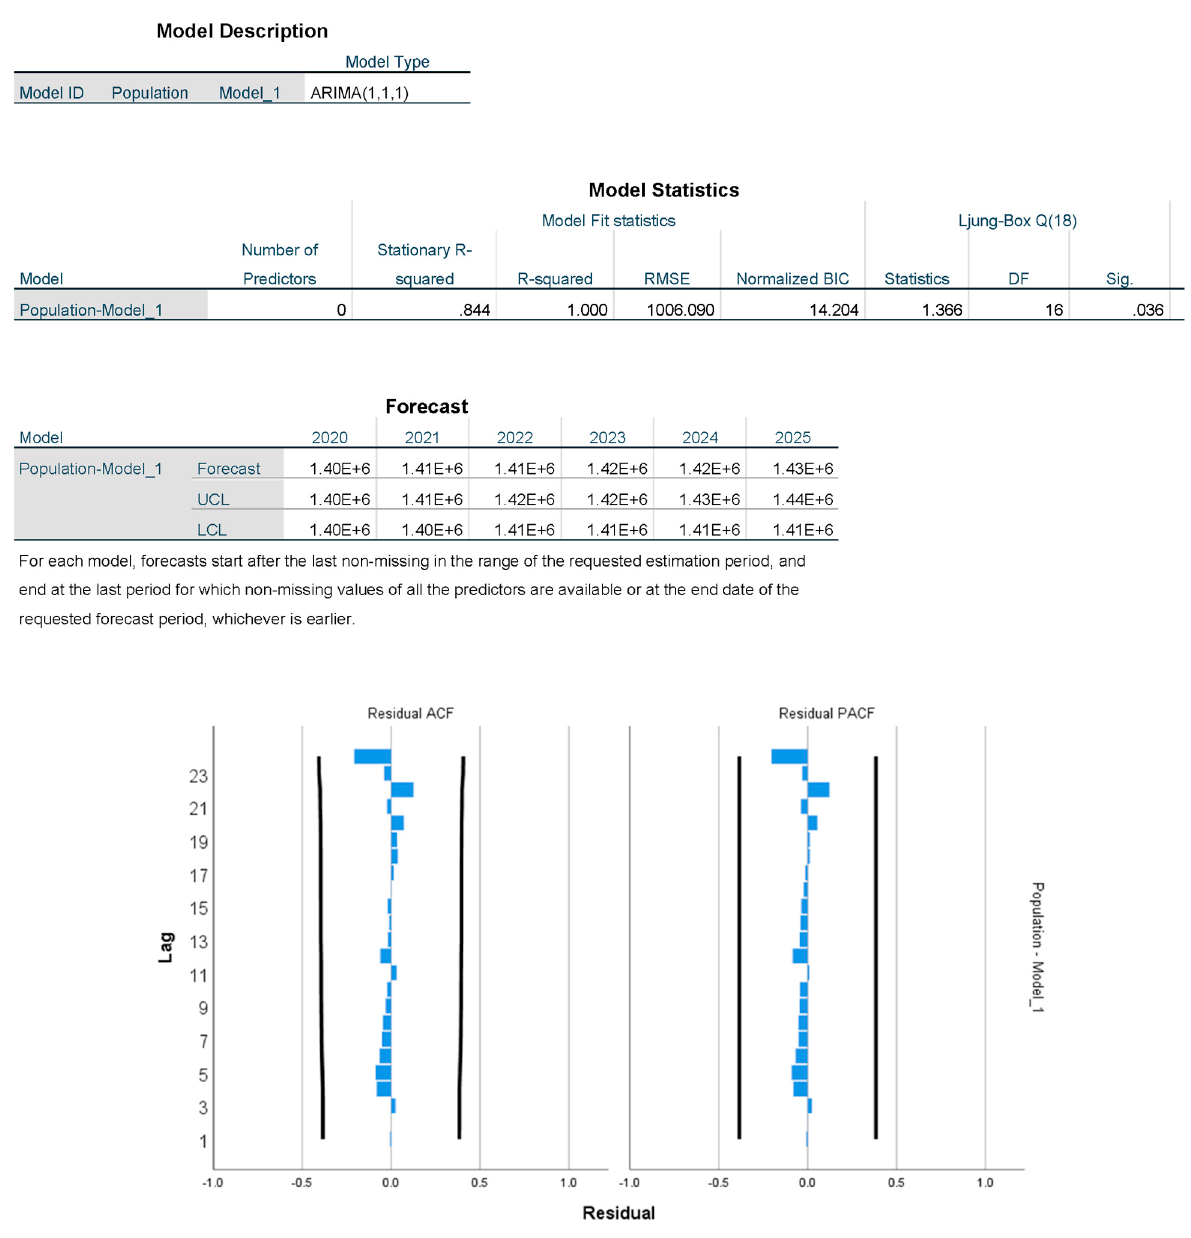
Figure A8. Model (4) Forecast in population.